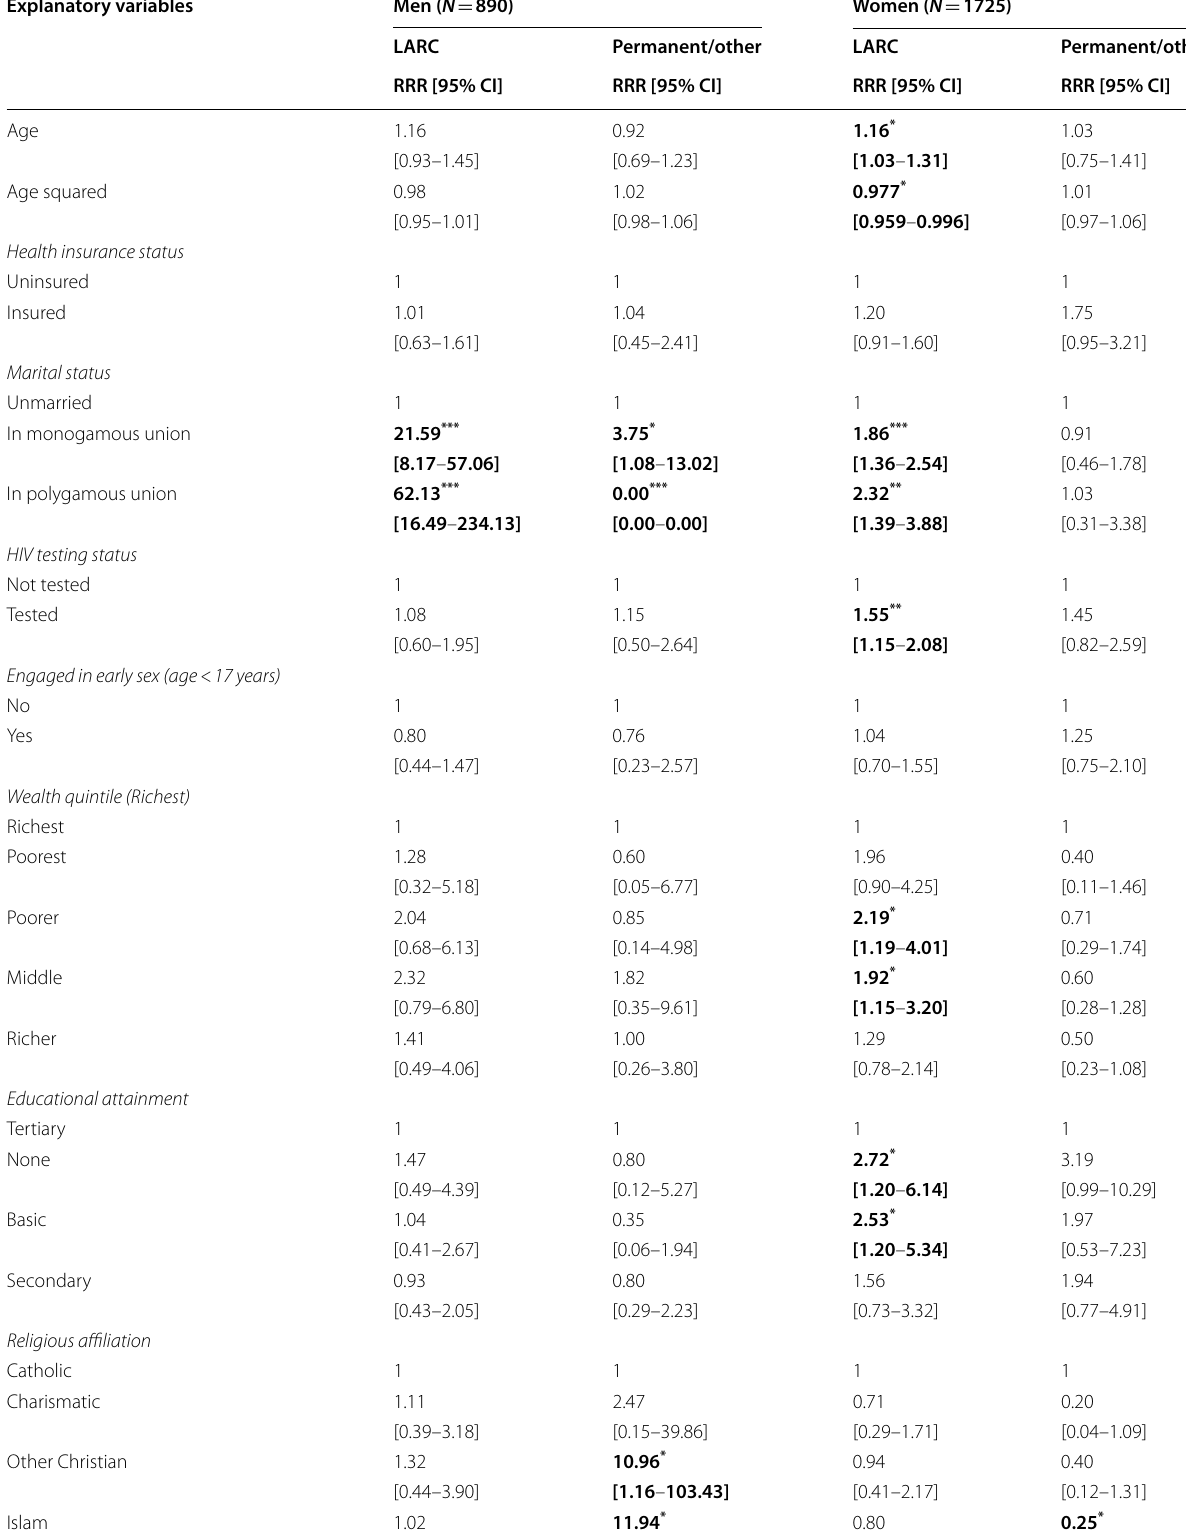
Table 5 Determinants of modern contraceptive